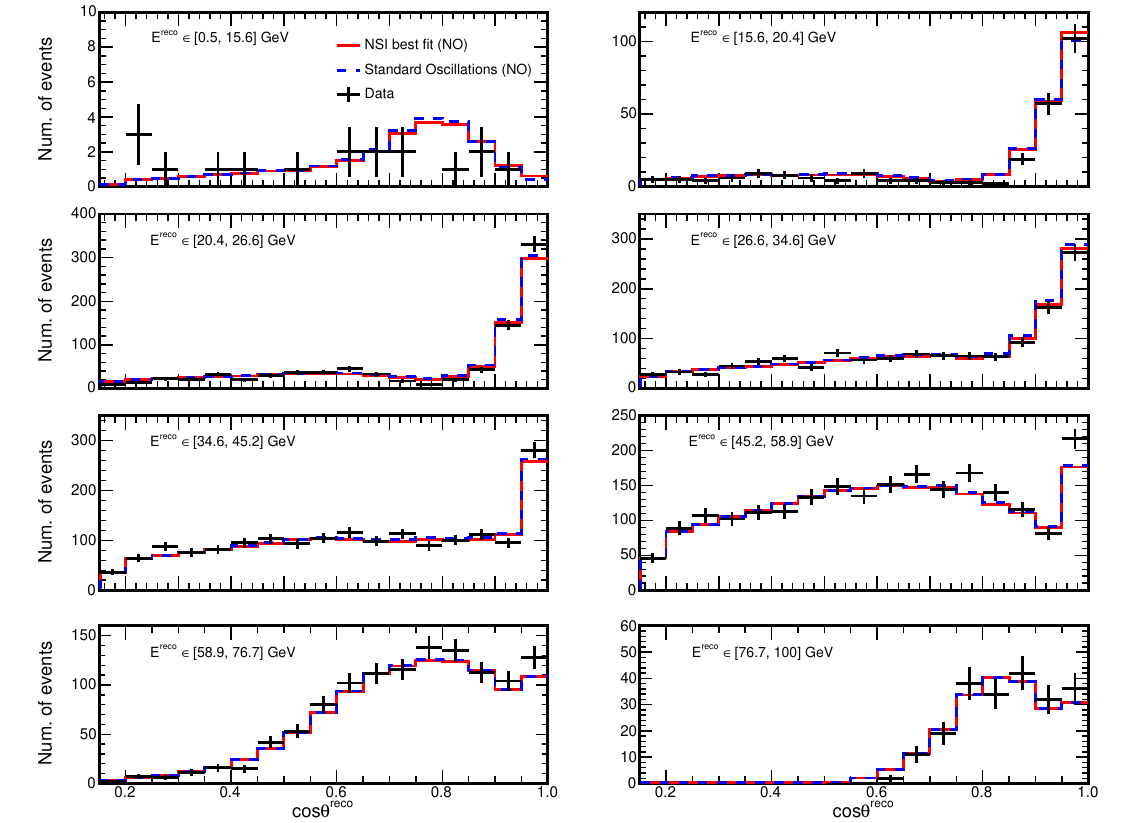
Figure 3 . Data (black points) and MC simulated events from this analysis, as a function of the reconstructed zenith angle, cos θ reco , for the eight different energy, E reco bins. The blue dashed histogram corresponds to the MC assuming standard oscillations and the (mostly overlapping) red histogram corresponds to the MC for the NSI case using the best-fit values obtained for normal ordering. Note the difference in Y-axis scales in different